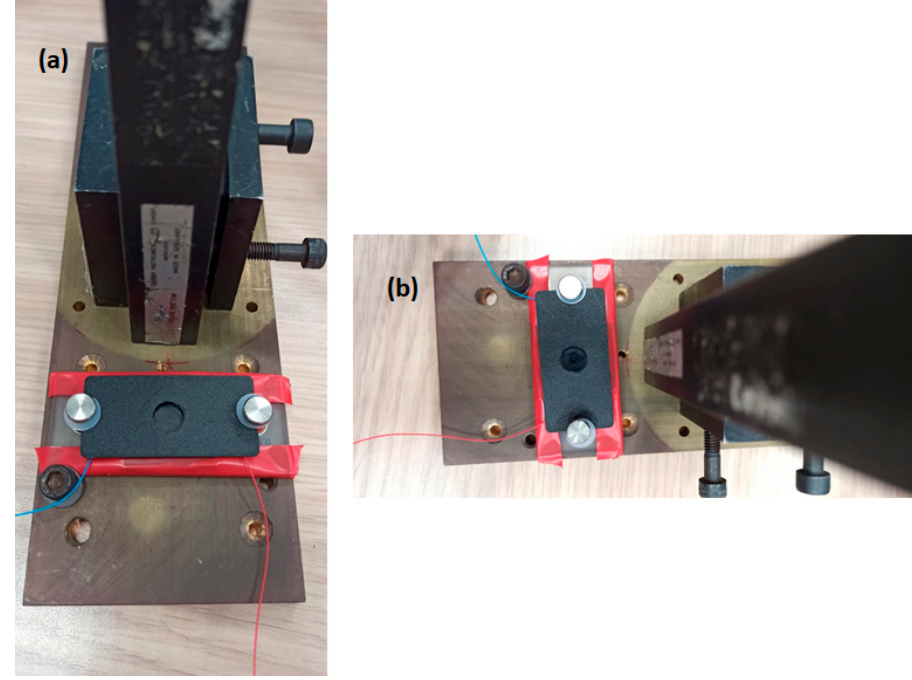
Figure 3. Photos of the sample cell. ( a ) front view ( b ) top view. In Figure 4, the scheme of the experimental setup is reported.